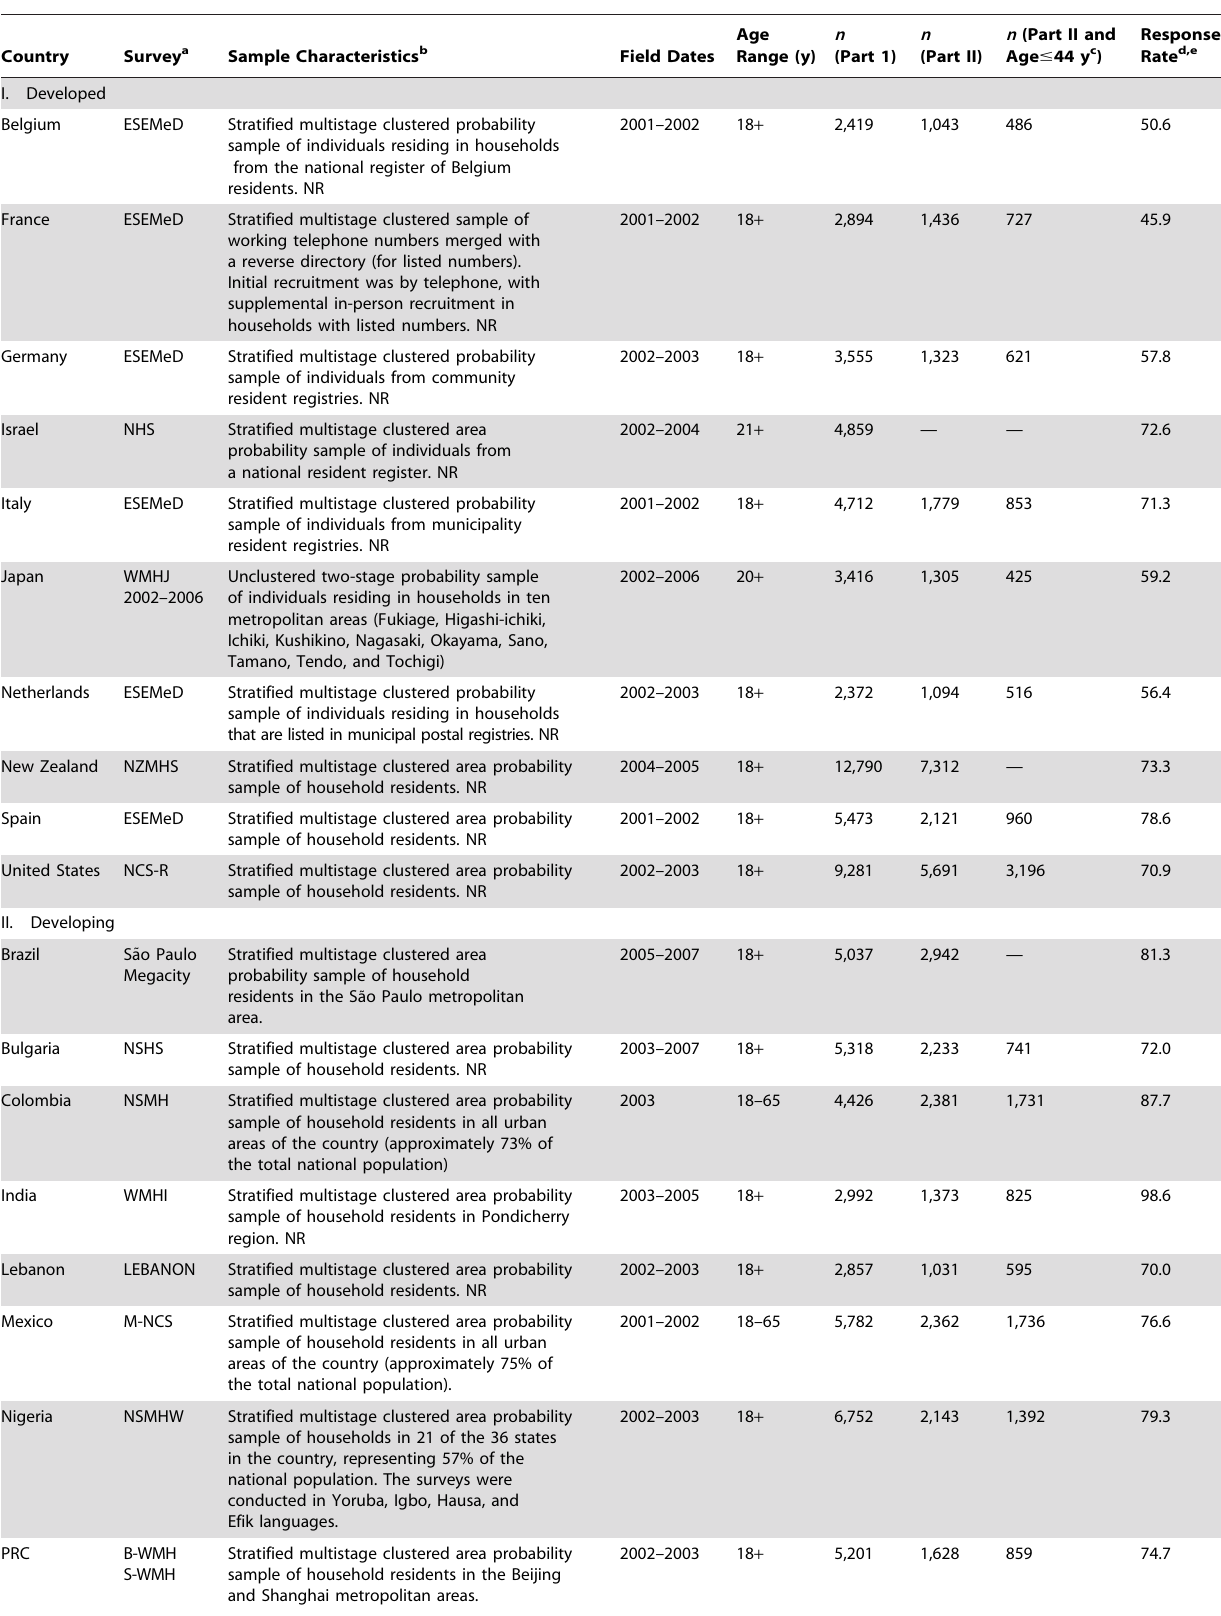
Table 1. WMH sample characteristics—developed and developing countries.